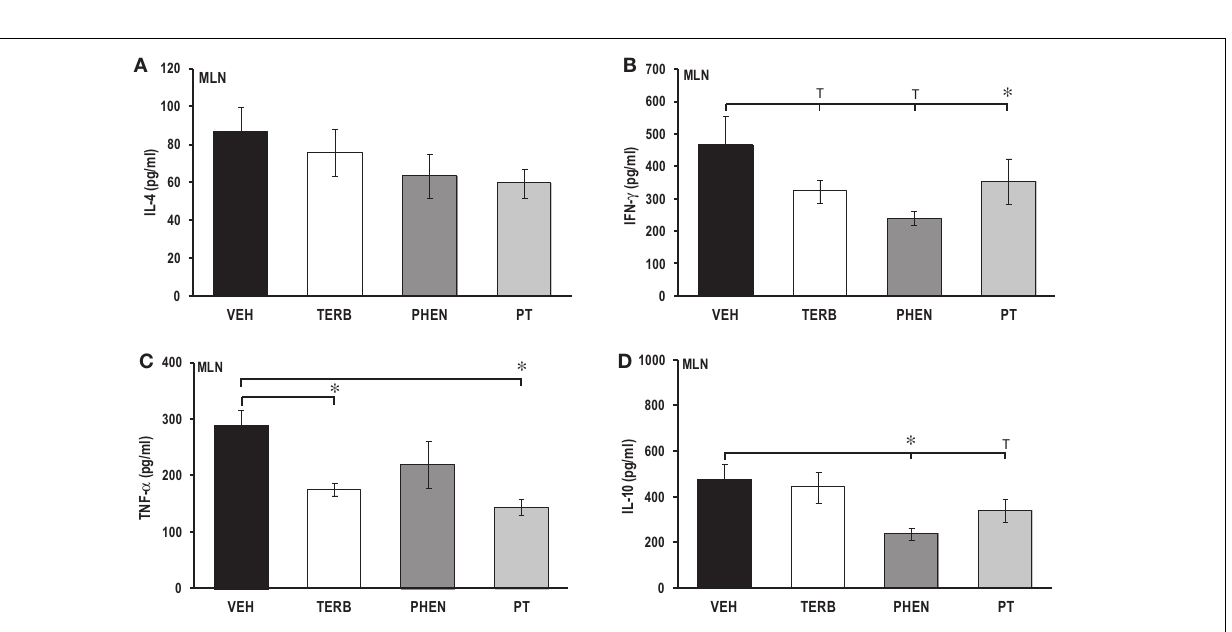
in all groups. N = 8. (B) IFN- γ concentrations were lower in PT- than with VEH-treated rats. N = 8. * p < 0.05. (C) TNF- α levels were reduced withTERB and PT treatment compared withVEH controls. N = 8. * p < 0.05. (D) IL-10 secretion was suppressed in rats treated with PHEN over that seen withVEH treatment. N = 8. * p <